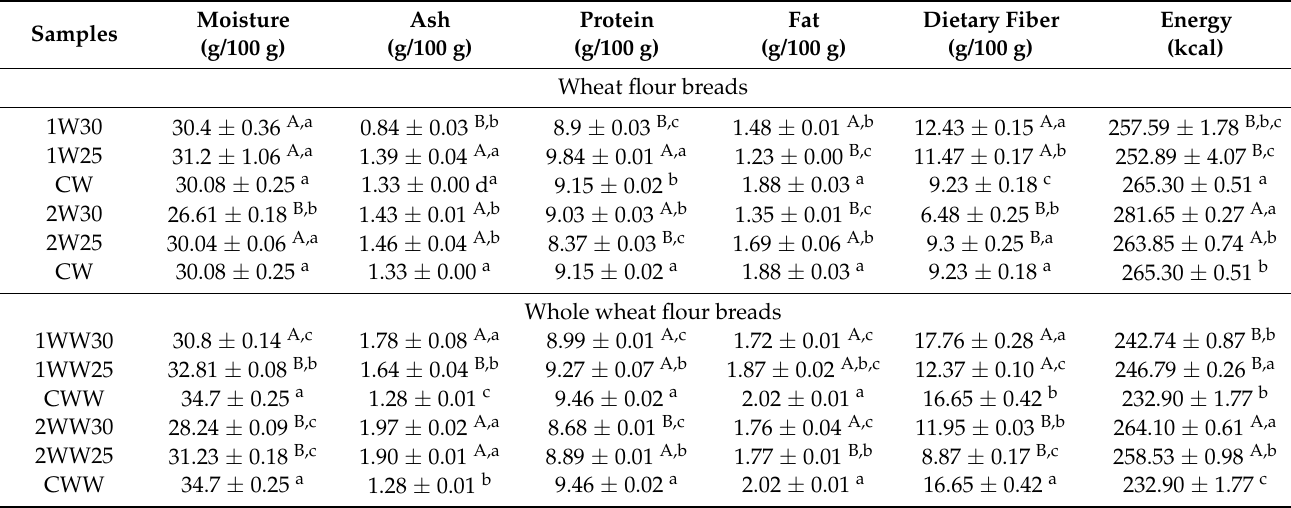
Table 5. Chemical composition of samples.